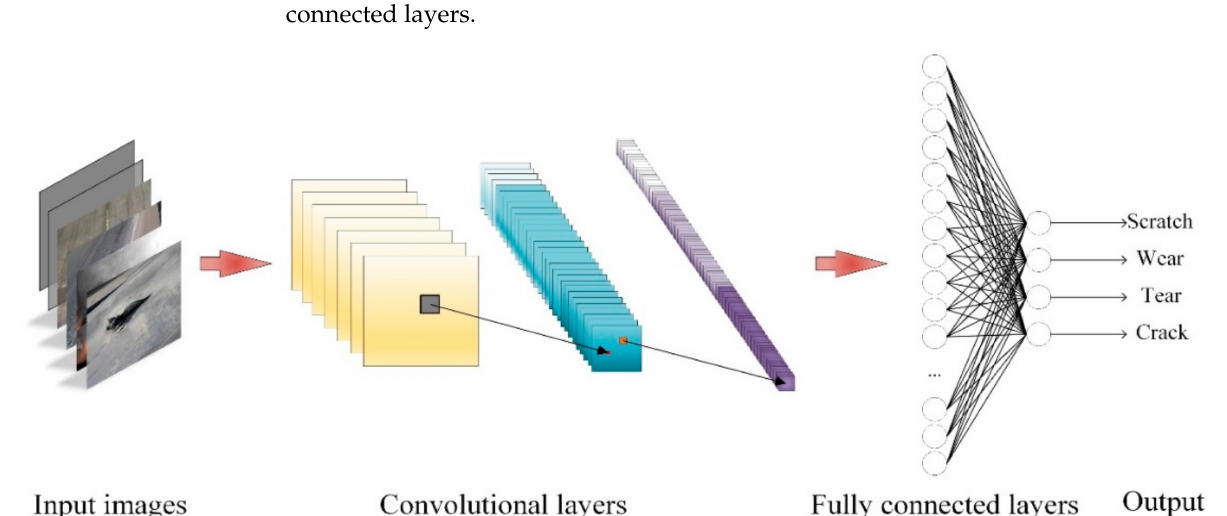
Figure 7. Pipeline of convolutional neural